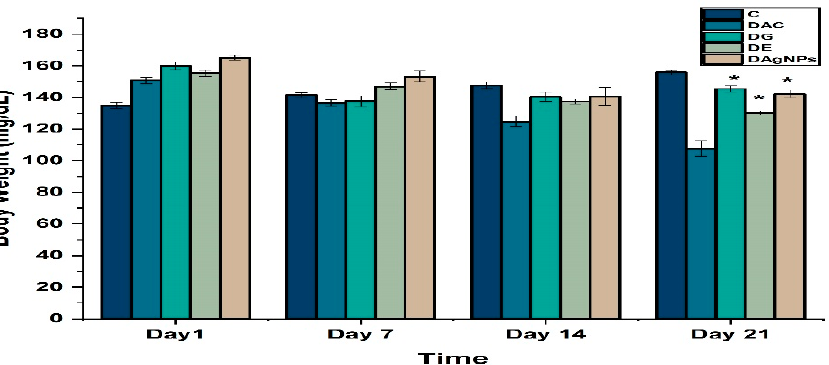
Figure 8. Body of various treated groups; * p < 0.05 reveals statistically difference between groups.